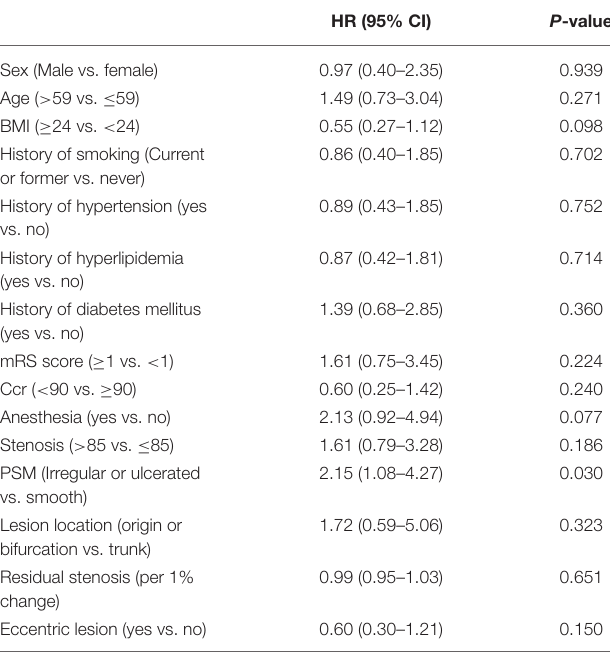
TABLE 3 | Results of competitive risk model for long-term